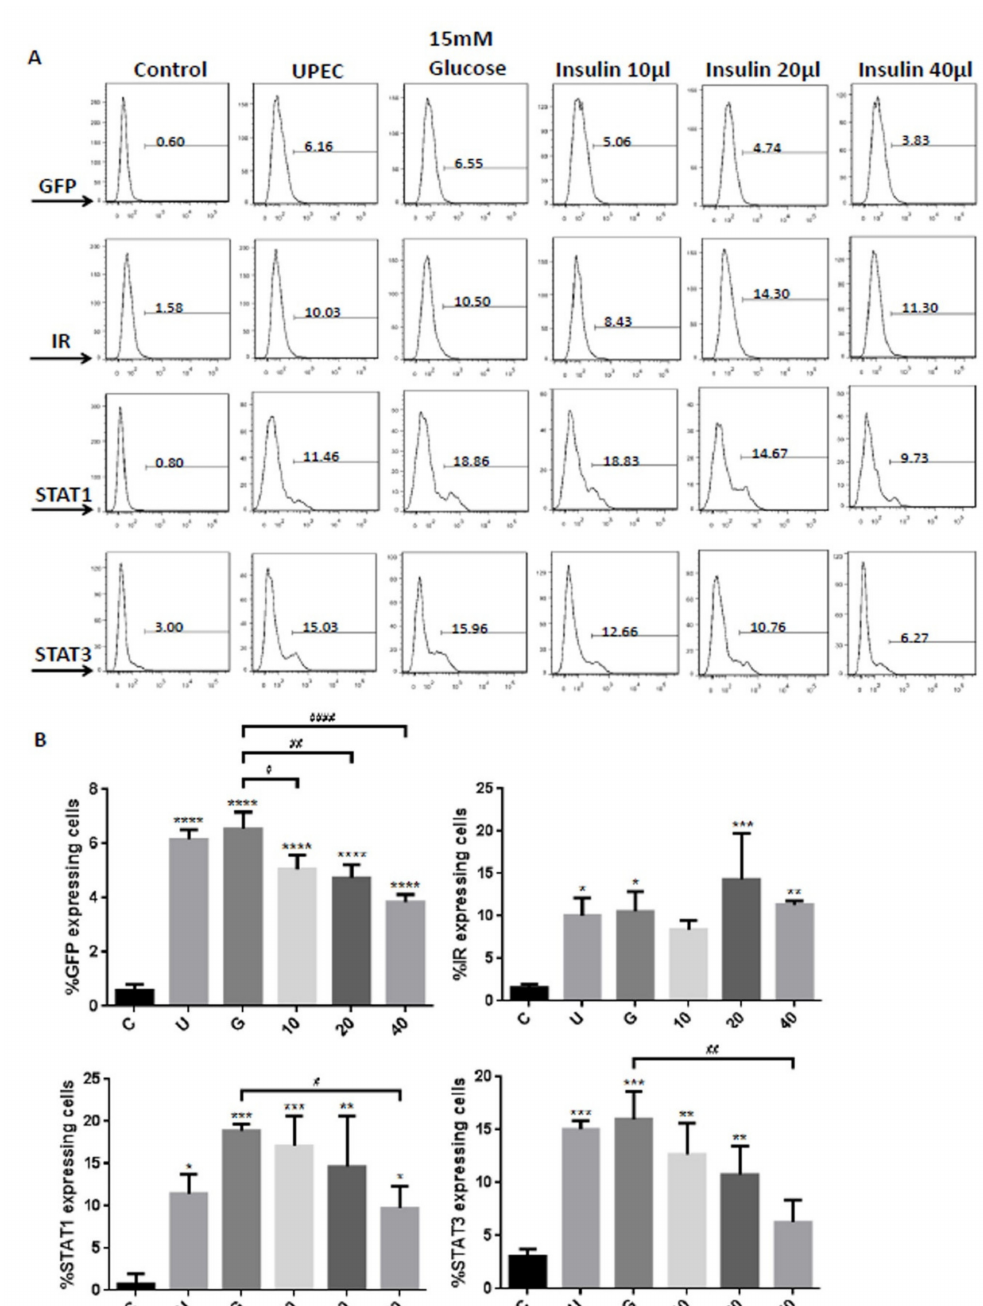
Figure 5. Insulin downregulated insulin receptor, STAT1, and STAT3 expression in UPEC-infected bladder cells. Flow cytometry data were obtained from insulin-pretreated UPEC-infected SV-HUC-1 cells in a high-glucose environment. ( A ) The frequency of GFP, insulin receptor (IR), STAT1, and STAT3 expression in uninfected and UPEC-infected bladder cells with or without different concentrations of insulin (10, 20, and 40 µ g/mL), and 15 mM glucose pretreatment for 24 h is shown as a histogram, and the results shown are representative of typical results. Numbers show the average frequency of GFP-, IR-, STAT1-, or STAT3 expressing cells. ( B ) Bars depict the data from three separate experiments and are expressed as mean ± SD. Cells with UPEC-infected cells alone were used as a positive control. The definitions of each letter/number represented by the X axis are: C: control; U: UPEC infection alone; G: with 15 mM glucose pretreatment; 10, 20 and 40: pretreated with 10, 20 and 40 µ g/mL insulin, respectively + 15 mM glucose. * p < 0.05; ** p < 0.01; *** p < 0.001, **** p < 0.0001, compared to positive control groups. # p < 0.05, ## p < 0.01, #### p < 0.0001, compared between the two